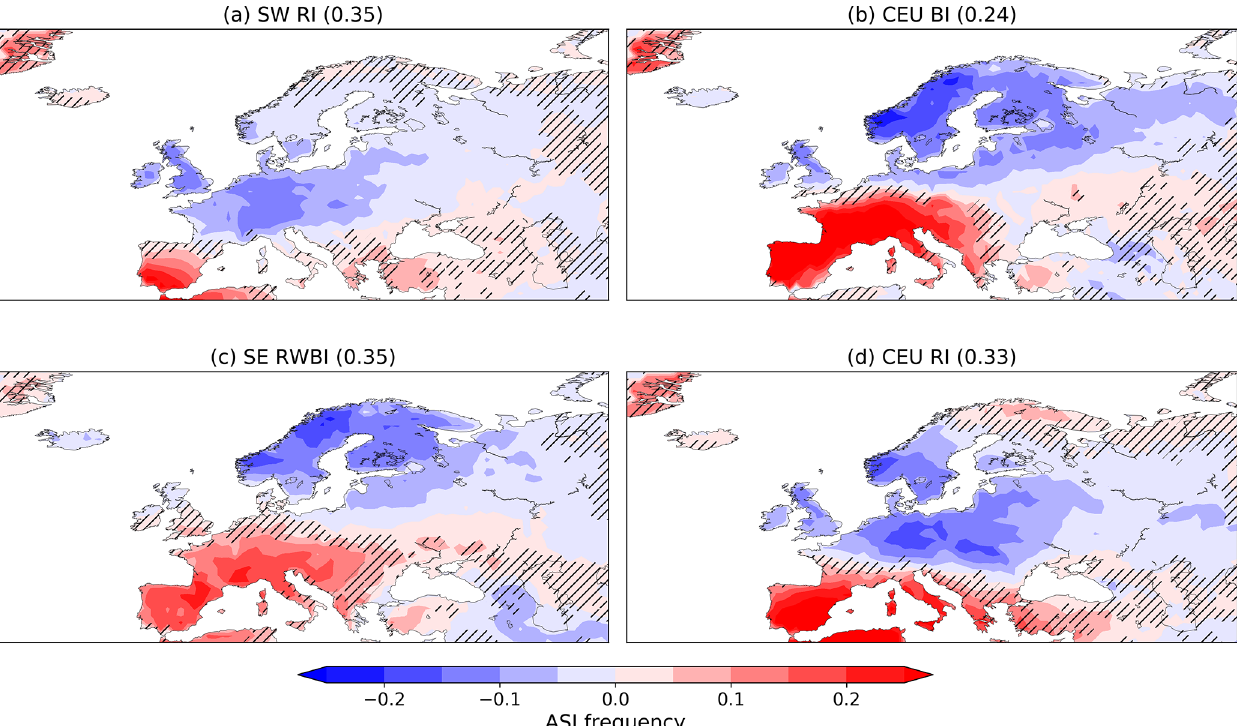
Figure 8. Composite departures (colour shading) and partial correlations (numbers in brackets on top of panels, based on monthly data) of stagnation occurrence in winter for days with (a) subtropical ridges in SW, (b) blocking in CEU, (c) Rossby wave breaking in SE and (d) subtropical ridges in CEU. These are among the five leading terms in the stepwise model for stagnation in SW winter. Hatching again denotes where there is no statistical significance ( p > 0 . 01) calculated using the approach described in Sect.